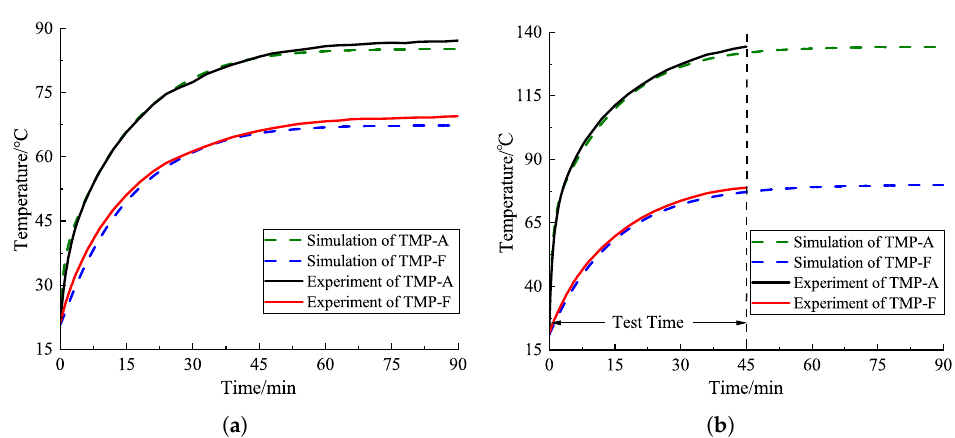
Figure 7. TR curve of normal and faulty motor. ( a ) Normal. ( b ) Forty-five-turn fault. The steady-state temperature and TR values before and after the fault of each TMP of the motor are listed in Table 5, and the TR of each TMP of the motor is quite different. In the normal motor, due to the poor heat-dissipation conditions at the junction box position, the TR at TMP-C is higher than that at TMP-A, -B, and -D of other windings. The TRs of TMP-E and -G at the slot bottom and the air-gap of the junction box are higher than those of TMP-F and -H on the opposite side. After the fault, the temperature of all TMPs increases noticeably, and the maximum value occurs in the faulty slot winding (TMP-A). The temperature-distribution law of other measuring points related to the position of the junction box is the same as that of the normal motor. Table 5. Comparison of TRs of TMPs before and after fault. (units: °C for temperature, K for TR).